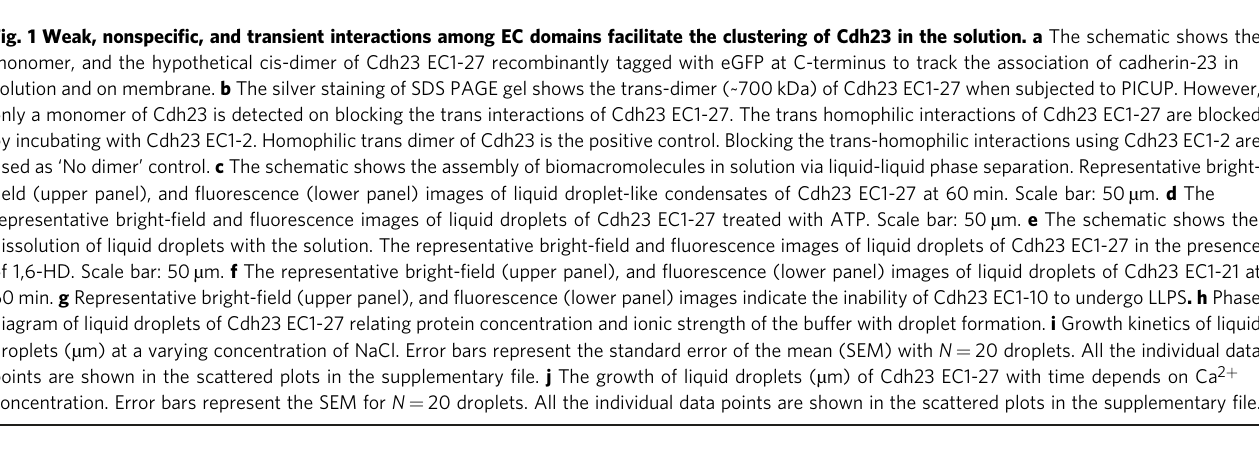
Table 1 Binding-af fi nities of the heterophilic and homophilic trans-complexes of Cdh23 as reported. Homo/Heterophilic dimer